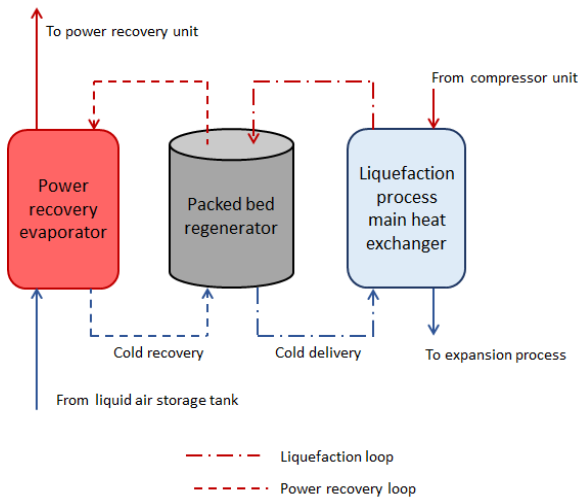
Figure 2. Simplified schematic of flow paths to the PBR during power recovery and liquefaction.